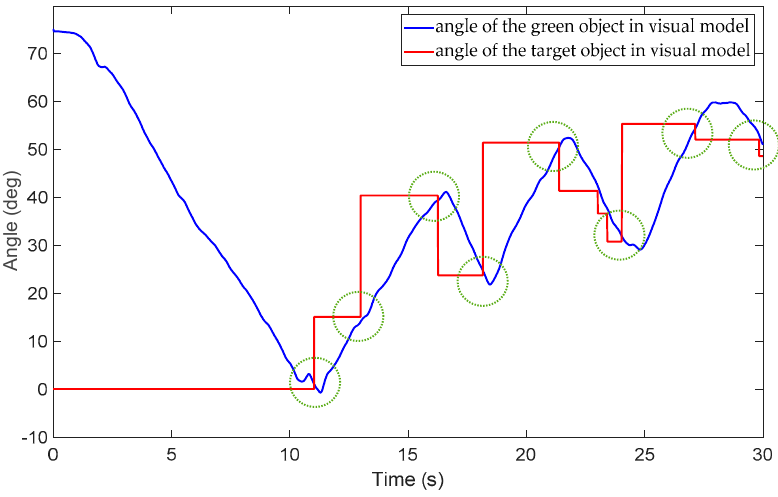
Figure 11. Position of the green object and target object in the visual model.